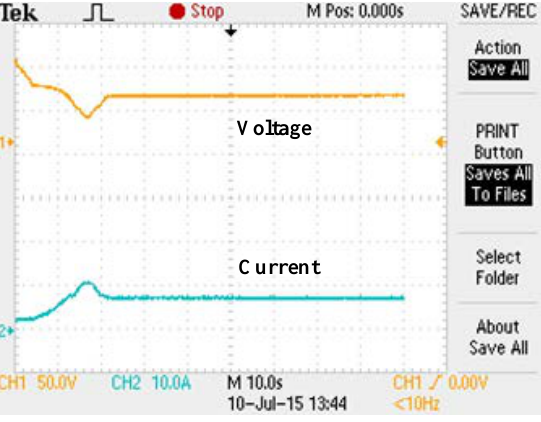
Figure 20. PV output power for the scenario of Figure 19.